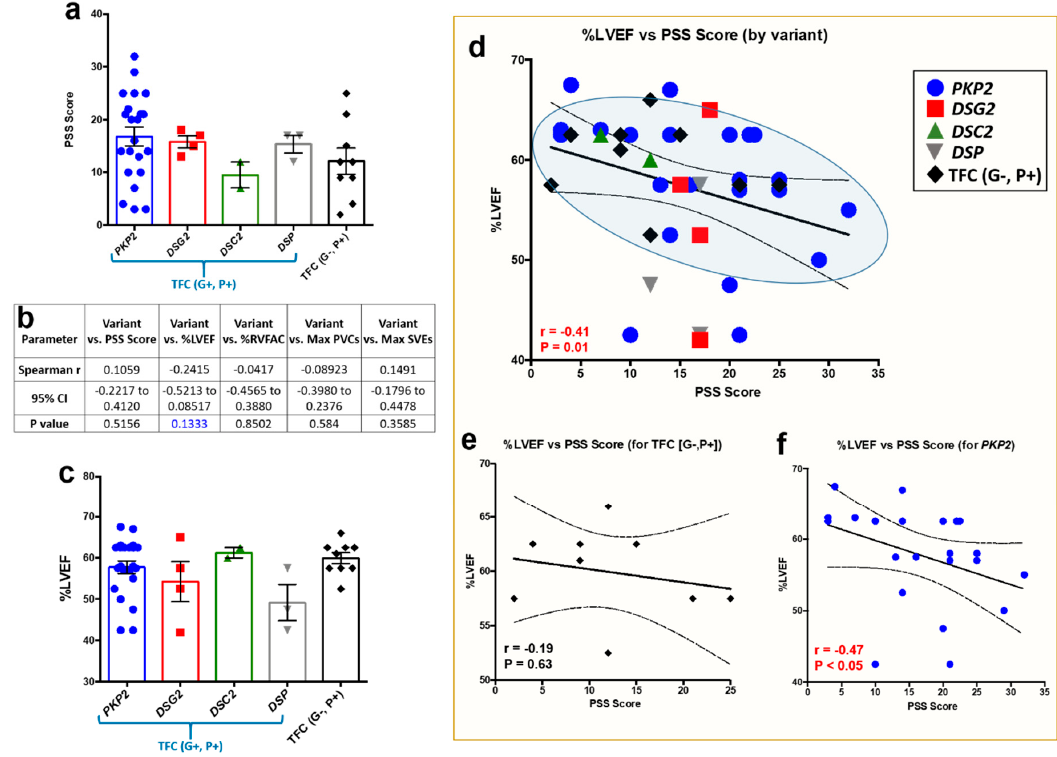
Figure 2. Multivariate analysis between perceived stress levels, pathogenic variant, and functional phenotypes in ACM patients. ( a ) PSS scores in n = 40 ACM patients, sorted by ACM patients with a pathogenic variant (i.e., TFC (G + , P + )) and gene-elusive patients (i.e., TFC (G − , P + )). No significance to note. ( b ) Multivariate analysis demonstrated a trend between presence of a pathogenic variant and %LVEF (noted in blue text). ( c ) Even though a trend was found between variant and %LVEF, no significant di ff erences in %LVEF were found between cohorts. ( d ) However, color-coating each data point by variant or gene-elusive status indicated PKP2 patients (blue circles) and TFC (G − , P + ) patients (black diamonds) abundantly fell within the 95% confidence interval between PSS scores and %LVEF correlation analysis. ( e , f ) Yet, only PKP2 patients showed a strong correlation between PSS scores and %LVEF. For ( a , c ), data presented as mean ± SEM. For ( d – f ), data displayed in scatterplots; thick black line shows the best linear fit through the data; dotted lines represent two-tailed 95% confidence interval; text inset reports Spearman’s Rho value and associated p